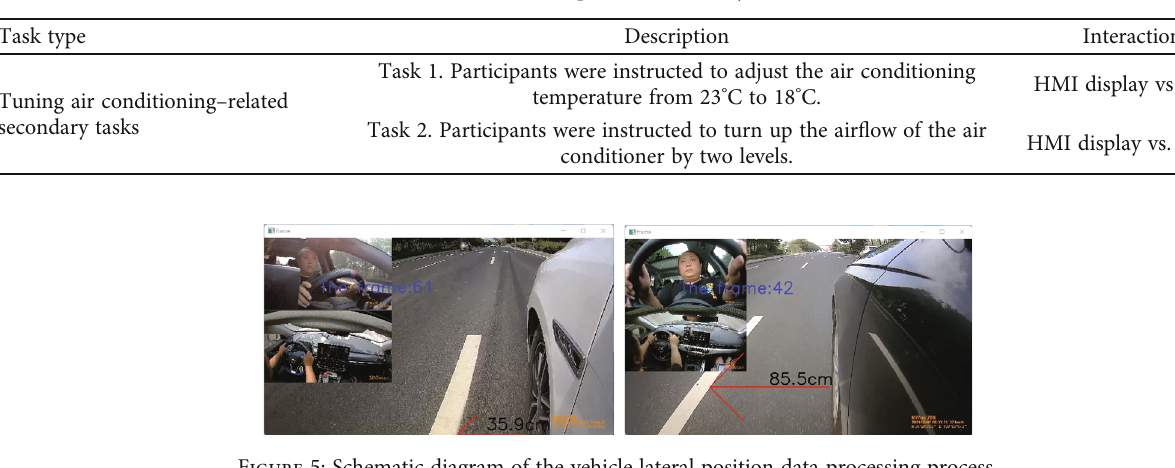
Figure 4: Operation process of secondary tasks in two interactive modes. Table 1: Description of secondary tasks.